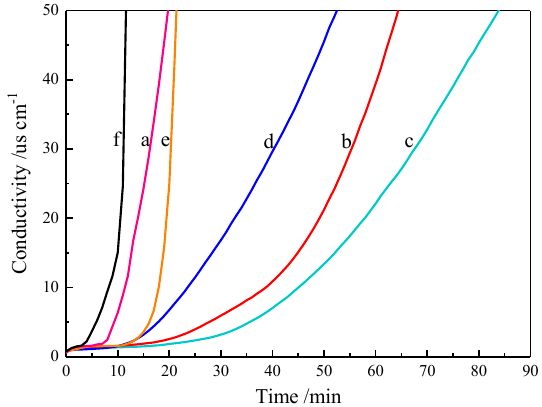
Figure 6. Conductivity versus time plots for pure PVC ( a ); and PVC stabilized by 4 phr of MSE-Al ( b ); MSE-Al/ZnSt 2 (3:1) ( c ); MSE-Al/ZnSt 2 (2:2) ( d ); MSE-Al/ZnSt 2 (1:3) ( e ); and ZnSt 2 ( f ). Table 1. Induction time and stabilization time for different PVC samples.